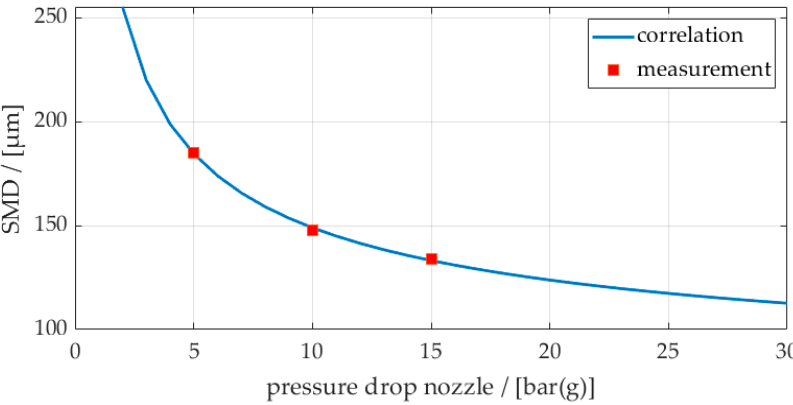
Figure 9. Dependency of the Sauter mean diameter (SMD) particle size on the fuel pressure drop for the fluidic injector. Measurement position is indicated in Figure 8a with ‘m’.